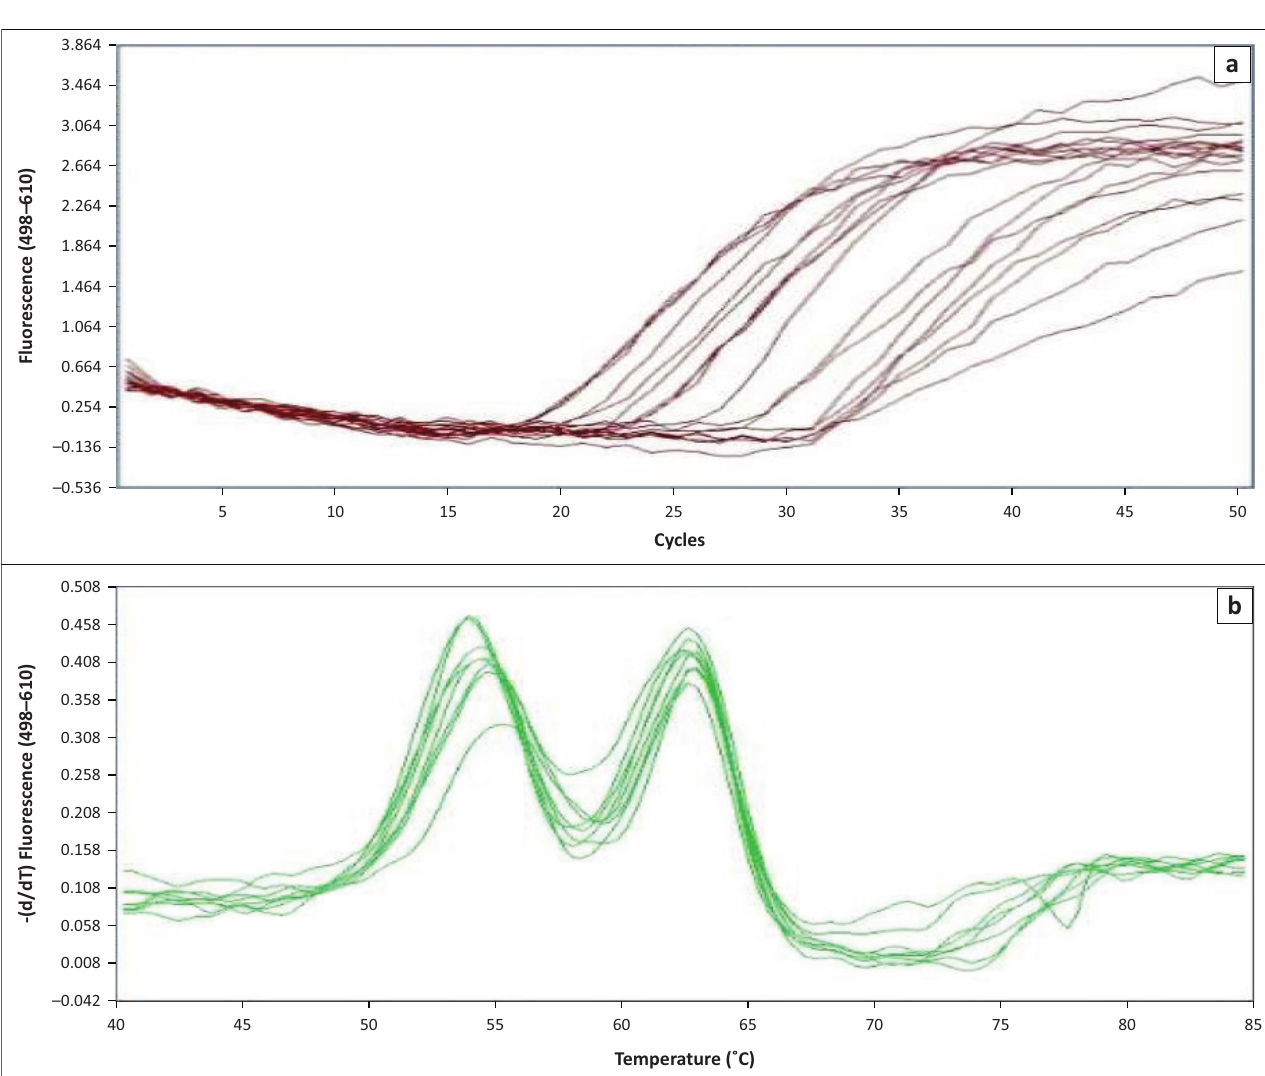
FIGURE 7: Amplification curves and melting peaks obtained on screening tryptic soy broth using the in-house optimised real-time polymerase chain reaction assay. (A) Amplification curves. (B) Melting peaks for the duplex real-time polymerase chain reaction